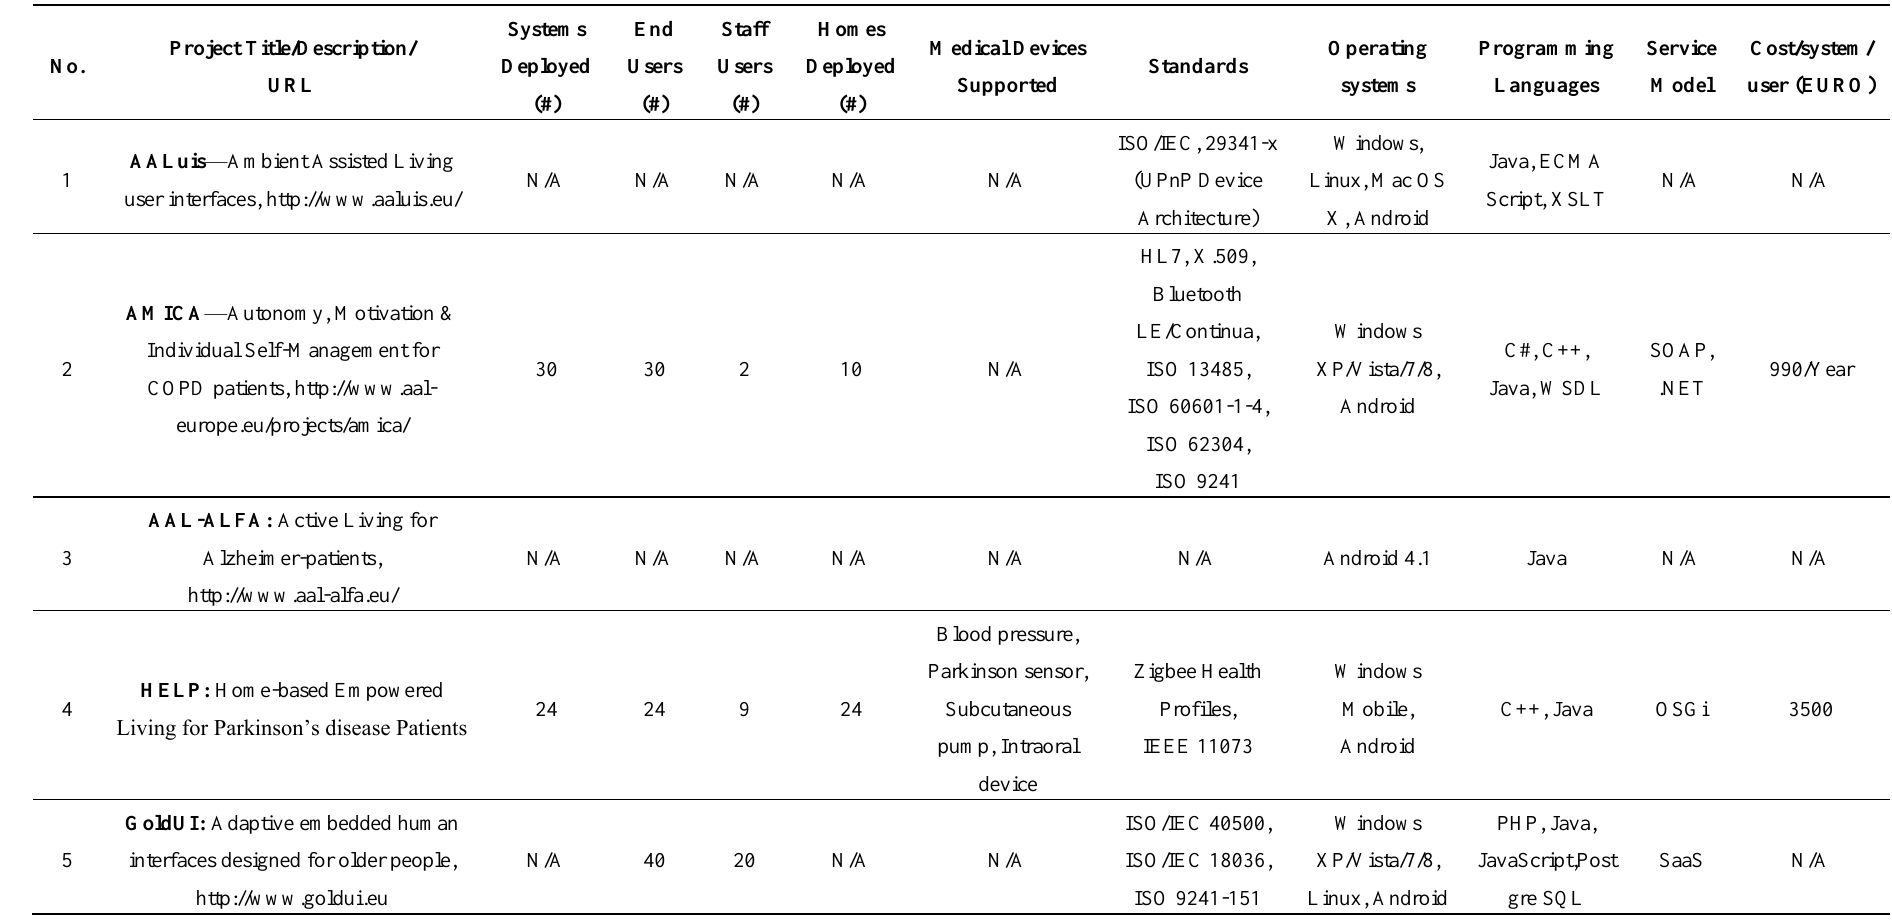
Table 2. Data showing usage of contemporary AAL platform and